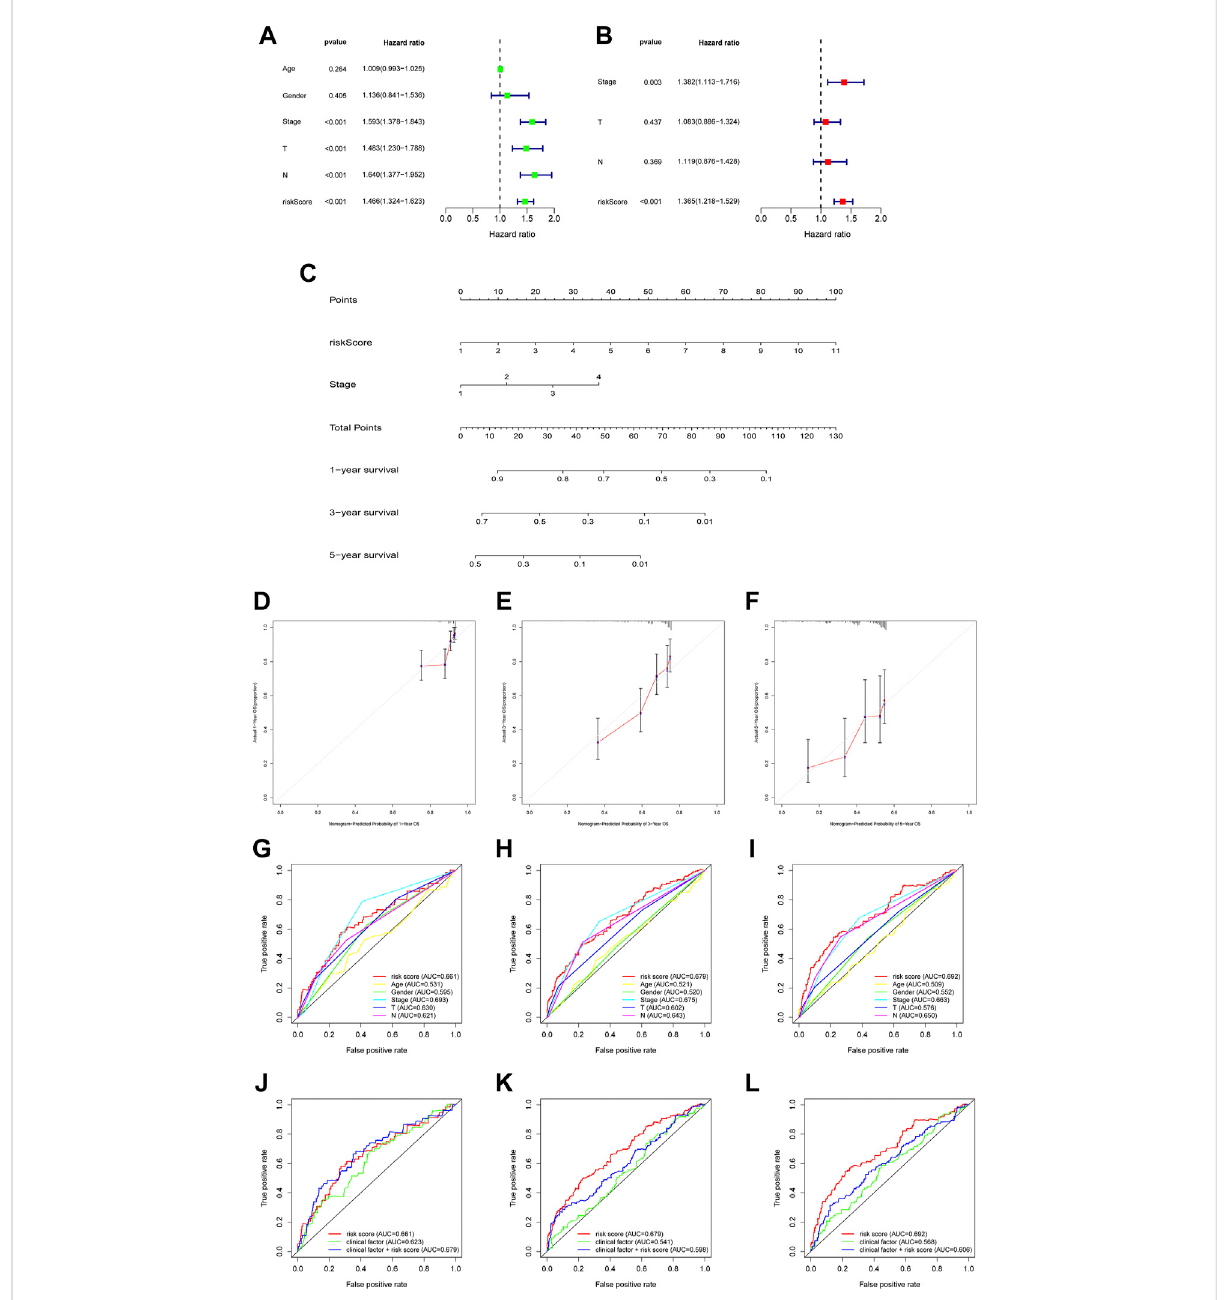
FIGURE 4 The construction and assessment of prognostic nomogram. (A,B) Univariate and multivariate Cox regression analyses were used to evaluate whether risk score and clinical characteristics were independent predictors. (C) A nomogram was constructed to predict OS (D – F) The calibration curvesofthenomogrambasedon1-,3-,and5-yearOS (G – I) TheROCcurveofriskscoreandclinicalcharacteristicswasperformedbasedon1-,3-, and 5-year OS (J – L) When combined risk score with clinical factors for analysis, the AUC values of 1-, 3-, and 5-year OS was